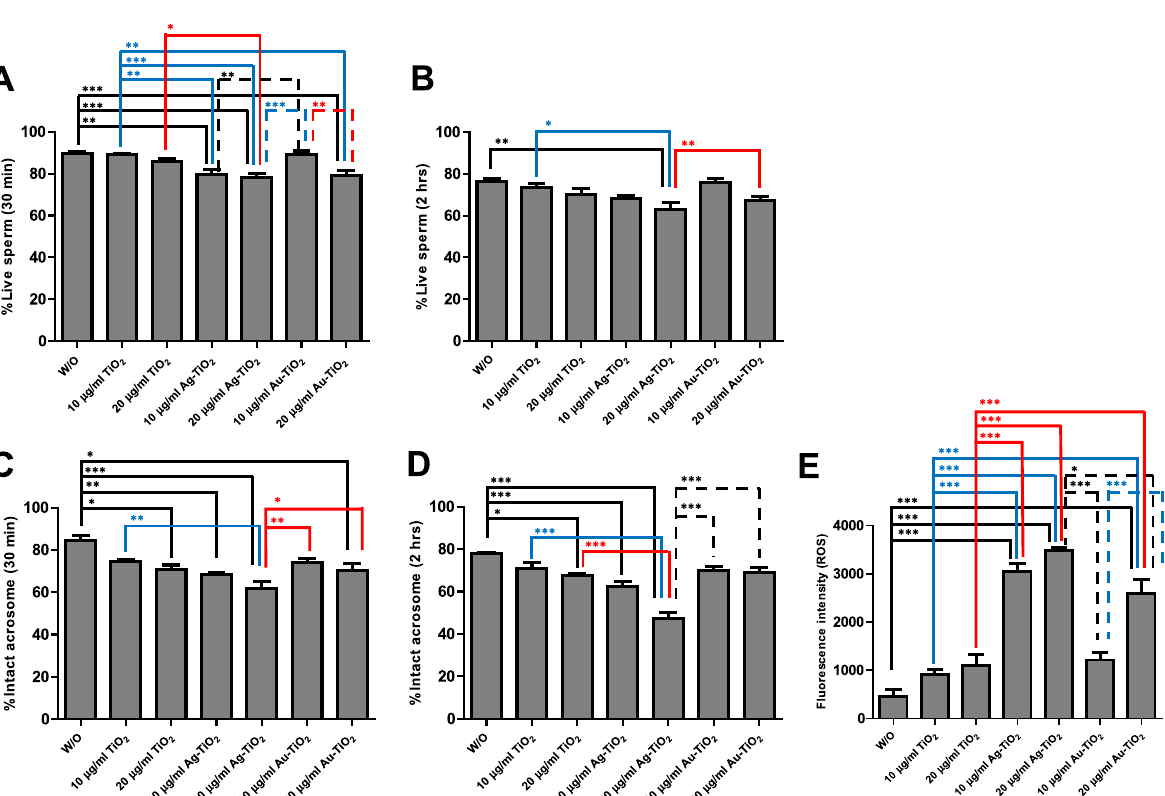
Fig. 4 Assessment of sperm viability and acrosomal integrity. Boar spermatozoa were incubated in the absence (W/O) or presence of NRs. Live (viable) spermatozoa were counted after incubation for 30 min ( A ) or 2 h ( B ). Also, intact acrosomes were examined using PNA and PI staining after incubation for 30 min ( C ) or 2 h ( D ). E Intracellular ROS generation in spermatozoa exposed to TiO 2 NRs. Fluorescence intensities were measured in sperm stained with carboxy‑DCFDA. Experiments were repeated five times with spermatozoa from two different boars. Values are expressed as mean SEM. Lines (or dotted lines) among columns denote significant differences at * p < 0.05, ** p < 0.01, and *** p < 0.001 ±